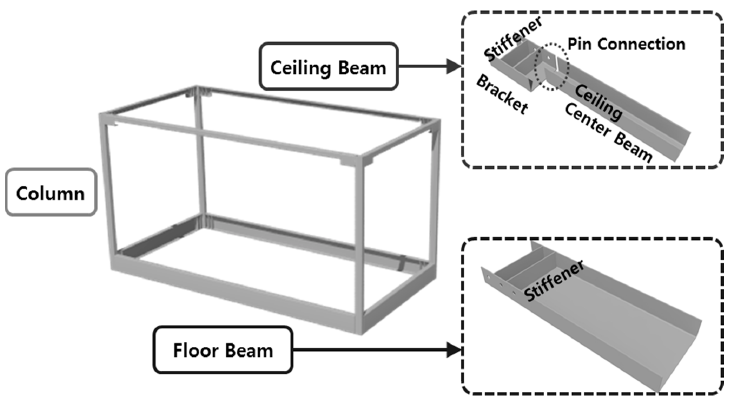
Figure 1. Steel frame modular unit.